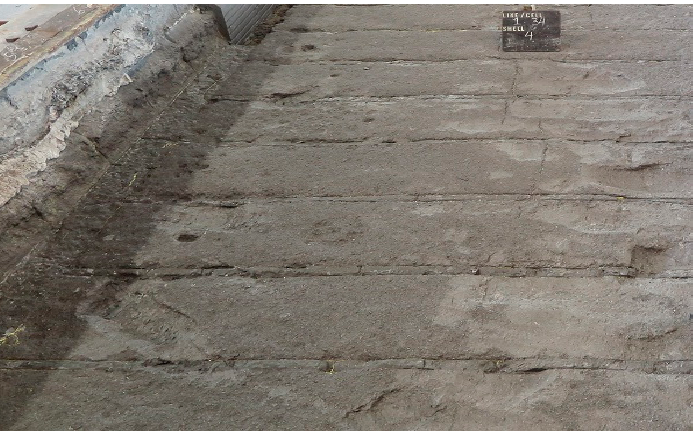
Figure 13. Cleaned D18 pot cavity with NeO 2 paste at 680 days.